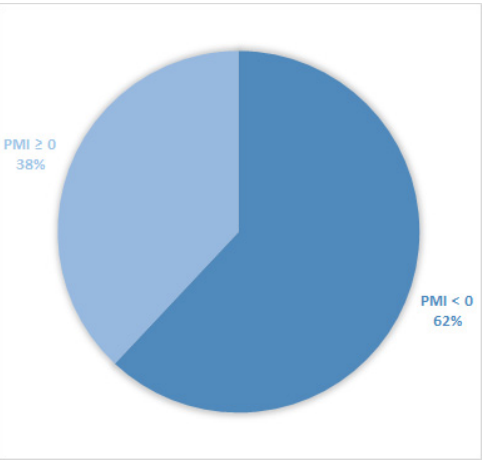
Figure 6. Pie chart displaying the percentage of patients with PMI < 0 and PMI ≥ 0. Only patients undergoing curative radiotherapy and with pain or receiving analgesics were included (680).